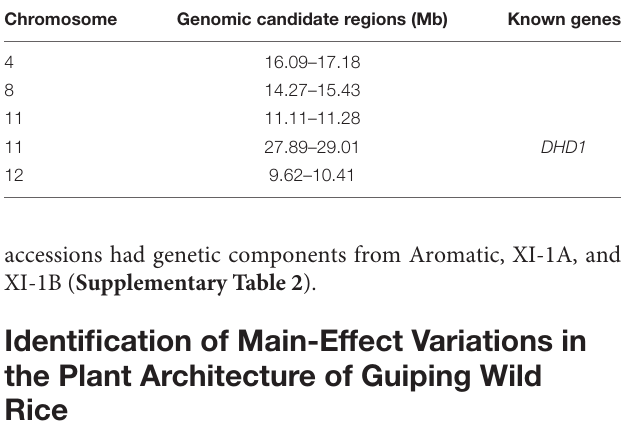
TABLE 2 | Final genomic candidate regions related to the plant architecture in the Guiping wild rice population.